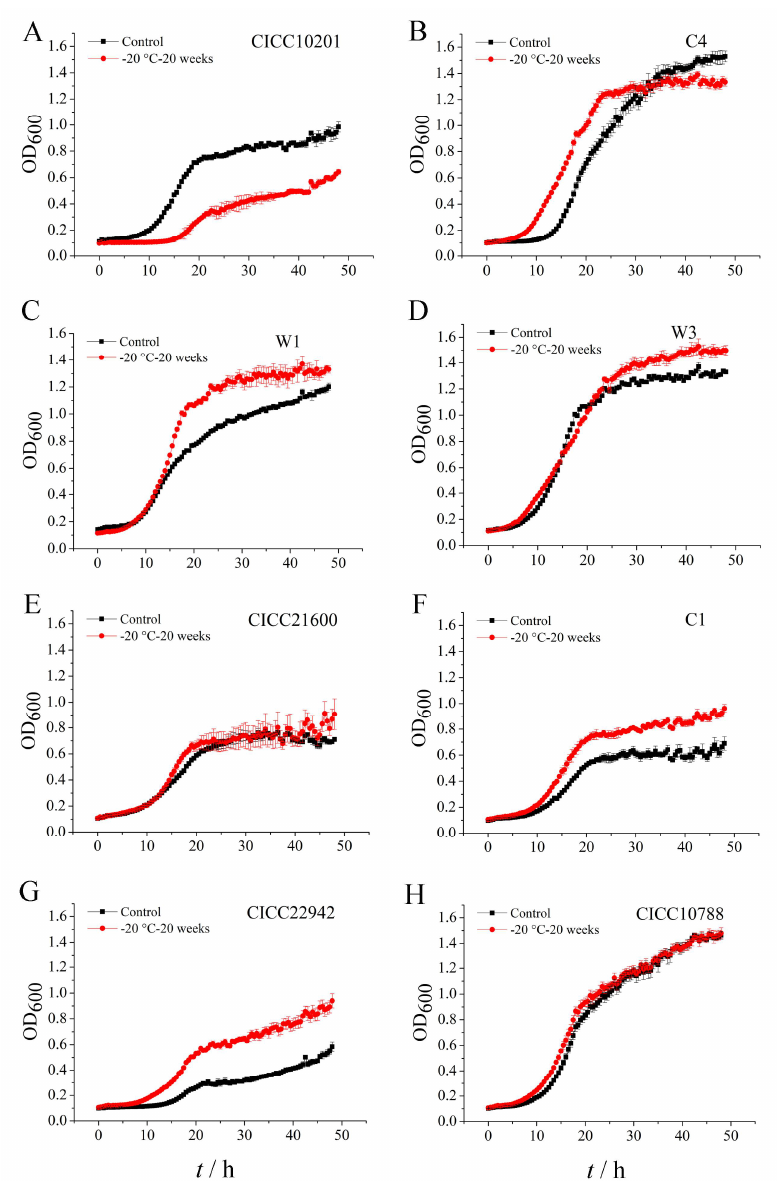
Figure 2. The growth of S. aureus biofilm cells after cold stress at − 20 ◦ C for 20 weeks. Note: The growth curve of biofilm cells of S. aureus CICC 10201 ( A ), S. aureus C4 ( B ), S. aureus W1( C ), S. aureus W3 ( D ), S. aureus CICC 21600 ( E ), S. aureus C1 ( F ), S. aureus CICC 22942 ( G ) and S. aureus CICC 10788 ( H ) was represented by the OD value at 600 nm. The biofilm cells of S. aureus strains without cold stress were used as control groups. The biofilm cells of S. aureus strains after cold stress at − 20 ◦ C for 20 weeks were used as treatment